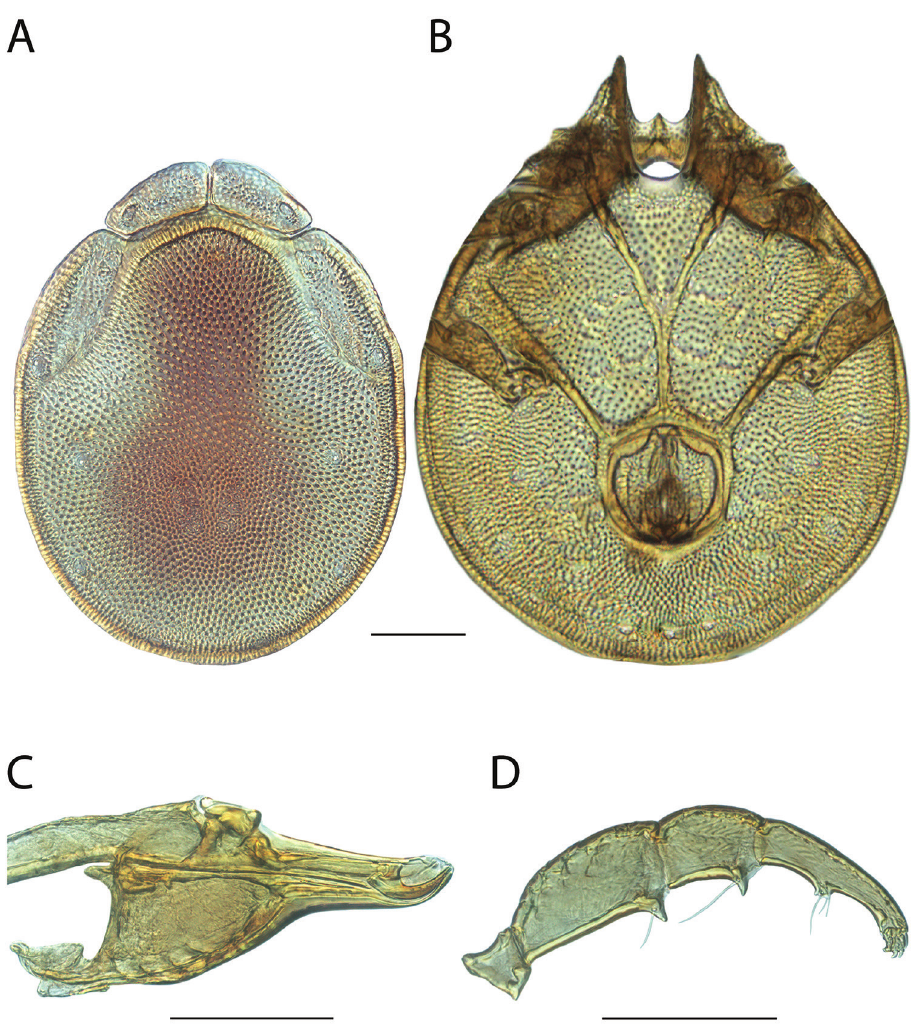
Figure 83. Torrenticola folkertsae sp. n. male: A dorsal plates B venter (legs removed) C subcapitulum D pedipalp (setae not accurately depicted). Scale = 100